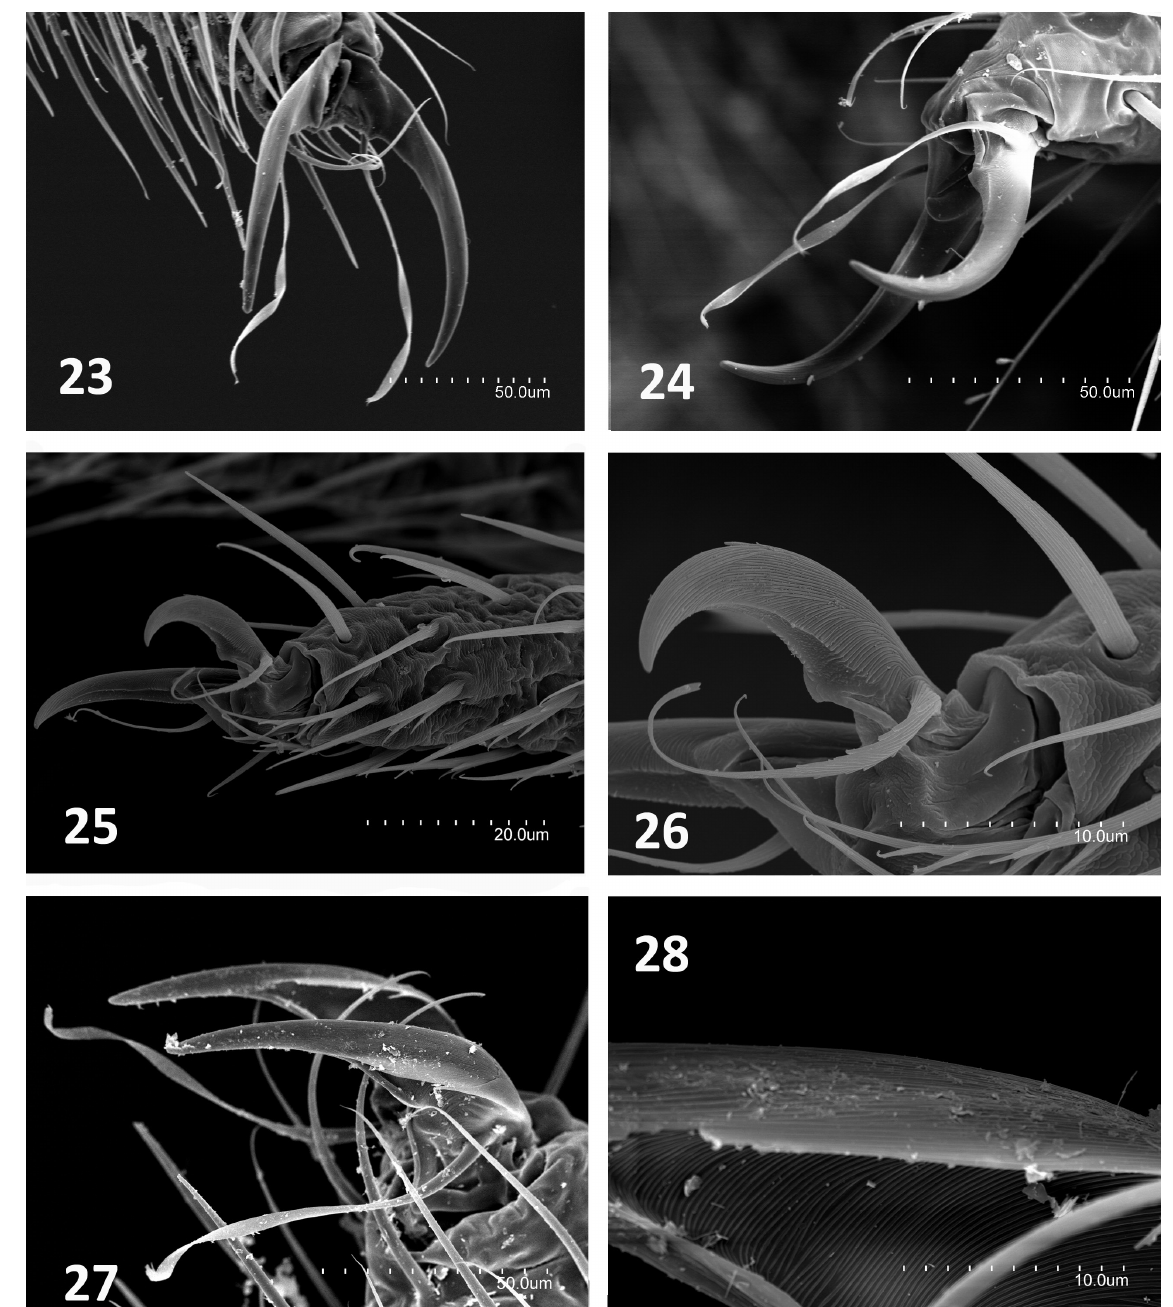
Figs 23–28. – 23 . Campodea ( Campodea ) maestrazgoensis Sendra & Escolà, 2004, pretarsus, metathoracic leg. – 24 . Campodea ( Campodea ) pieltaini Silvestri, 1932, pretarsus, metathoracic leg. – 25–26 . Campodea ( Monocampa ) devoniensis Bagnall, 1918. 25 . Pretarsus, metathoracic leg. 26 . Detail pretarsus, metathoracic leg. – 27–28 . Litocampa espanoli (Condé, 1949). 27 . Pretarsus, metathoracic leg. 28 . Detail pretarsus, metathoracic